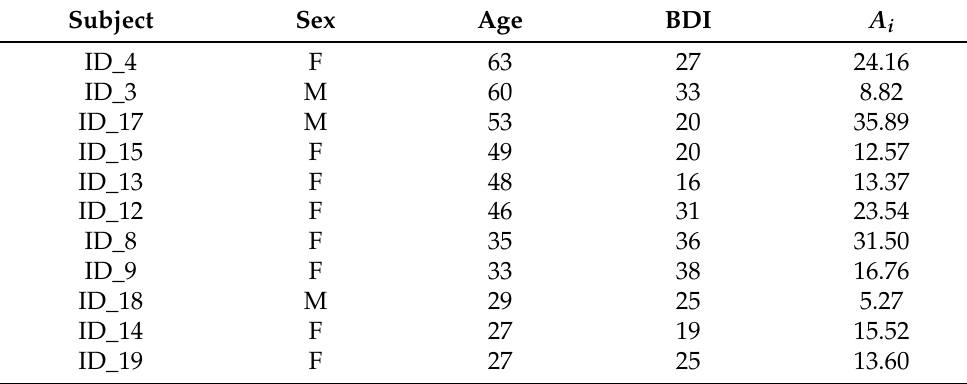
Table 4. Average variations ( A i ) in depressed